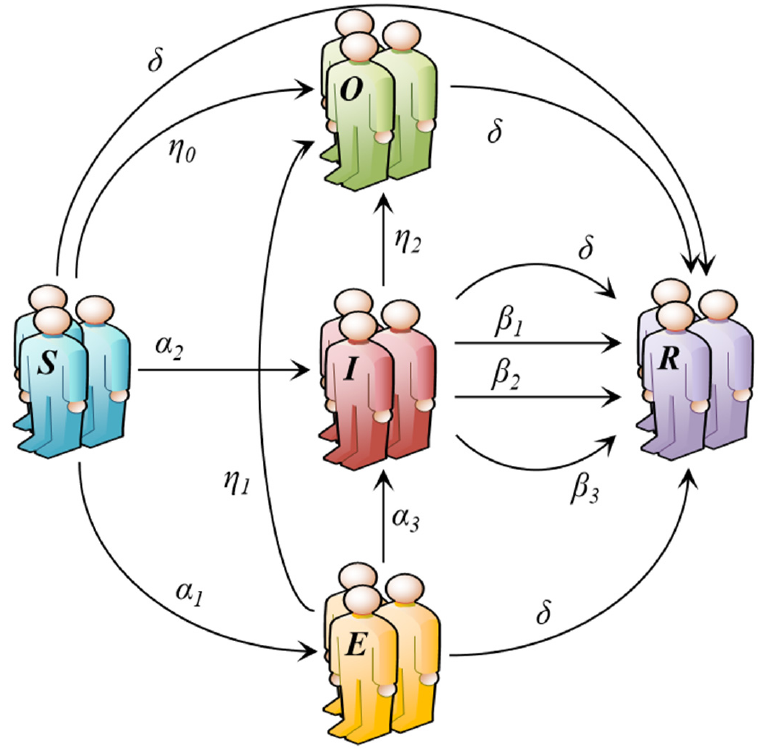
Figure 1. Structural diagram of the rumor propagation process of the SEIOR model.